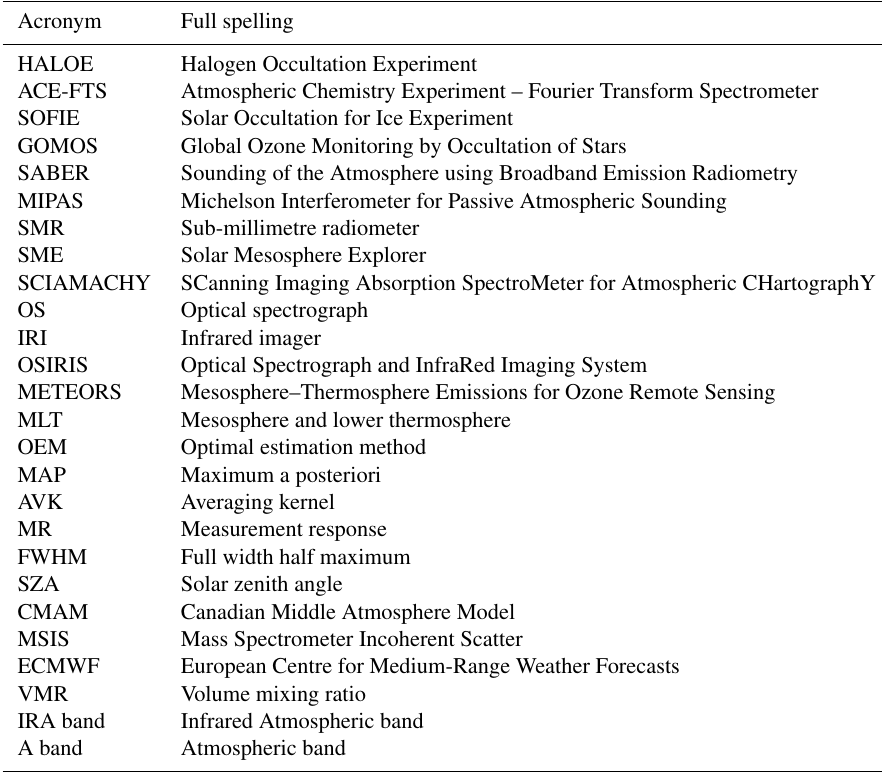
Table A2. A list of acronyms that have been used in the